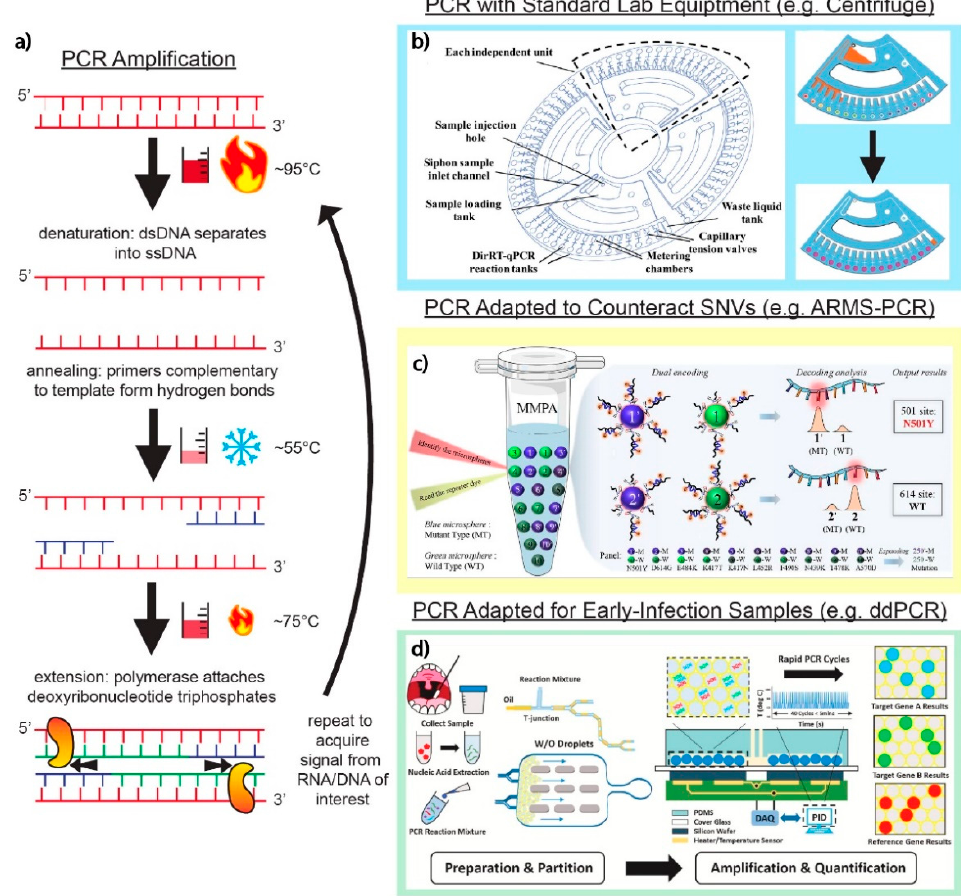
Figure 2. PCR techniques and applications. ( a ) Basic schematic of the core PCR amplification steps. The dsDNA containing the targets of interest are denatured into two separate ssDNA strands. Hybridization of primers complementary to target sequences of interest signals DNA polymerase to amplify ssDNA targets through thermocycling. ( b ) Adaptation of a standard laboratory centrifuge into a fully customizable disc that allows for PCR into 64 independent direct RT-qPCR across four independent loading units. Adapted with permission from Ref. [42]. Copyright 2020, Royal Society of Chemistry. ( c ) The utilization of fluorescent microspheres (MPA enhanced ARMS-PCR platform) for the amplification of fluorophores on primers targeting genes of interest in the detection of SARS- CoV-2. Adapted with permission from Ref. [48]. Copyright 2022, Elsevier. ( d ) Decreasing the signal-to-noise ratio of genomic target to background interference using the ddPCR platform. As shown in this platform, a series of microfluidic channels create individual droplets, which can then be separated into individual bioreactor units on a silicon chip. Adapted with permission from Ref. [60]. Copyright 2021,